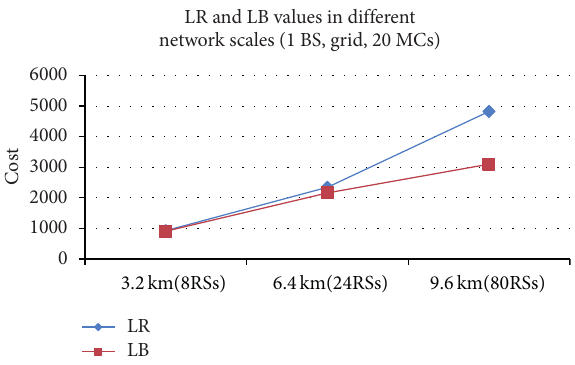
Figure 15: Deployment cost and lower bound (LB) values in differ- ent network scales (1BS, grid, 20